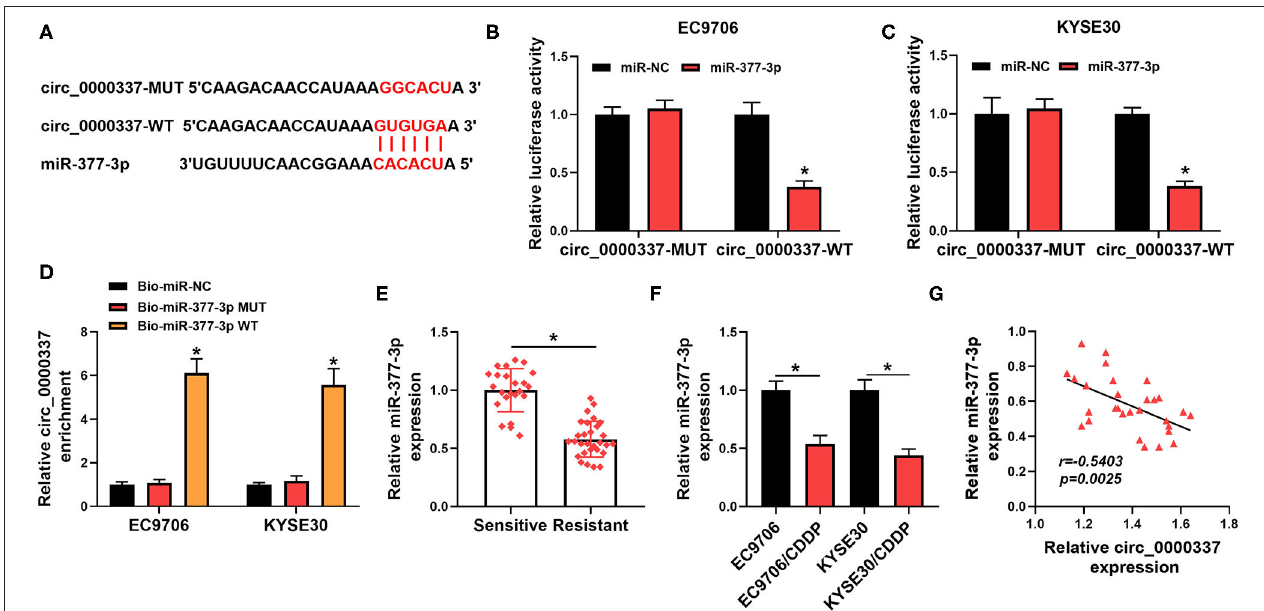
FIGURE 4 | MiR-377-3p acted as a target of circ_0000337. (A) Circinteractome software was applied to predicate the binding sites between circ_0000337 and miR-377-3p. (B,C) The potential binding relationship between circ_0000337 and miR-377-3p in EC9706 and KYSE30 cells was verified by a dual-luciferase reporter assay. (D) RNA pull-down assay was conducted to verify the interaction between circ_0000337 and miR-377-3p using Bio-miR-377-3p WT, Bio-miR-377-3p MUT, or Bio-miR-NC in EC9706 and KYSE30 cells. (E) The expression level of miR-377-3p was measured in the chemosensitive group ( n = 23) and the chemoresistant group ( n = 29). (F) MiR-377-3p level was detected in EC9706, EC9706/CDDP, KYSE30, and KYSE30/CDDP cells. (G) Pearson correlation analysis was conducted to assess the expression association between circ_0000337 and miR-377-3p in esophageal cancer tissues. * P < 0.05.